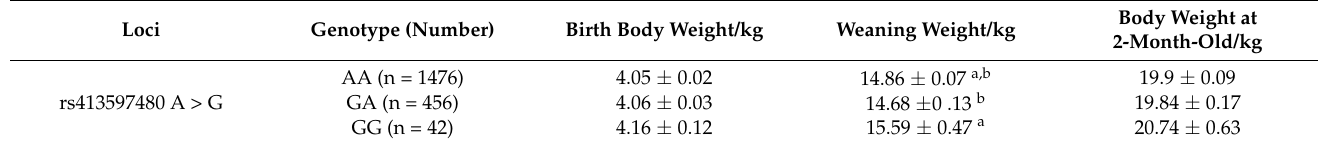
Table 3. Association analysis between the ARNT gene polymorphisms and growth traits of Hu sheep from birth to 2-month-old.